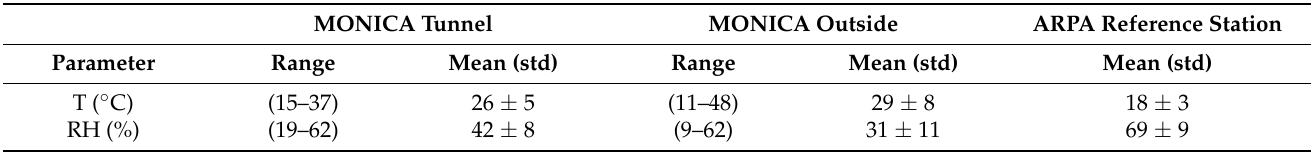
Table 1. Temperature and RH for MONICA monitors installed inside the tunnel, on the Viaduct San Paolo and by the ARPA reference station in the trimester April–June.